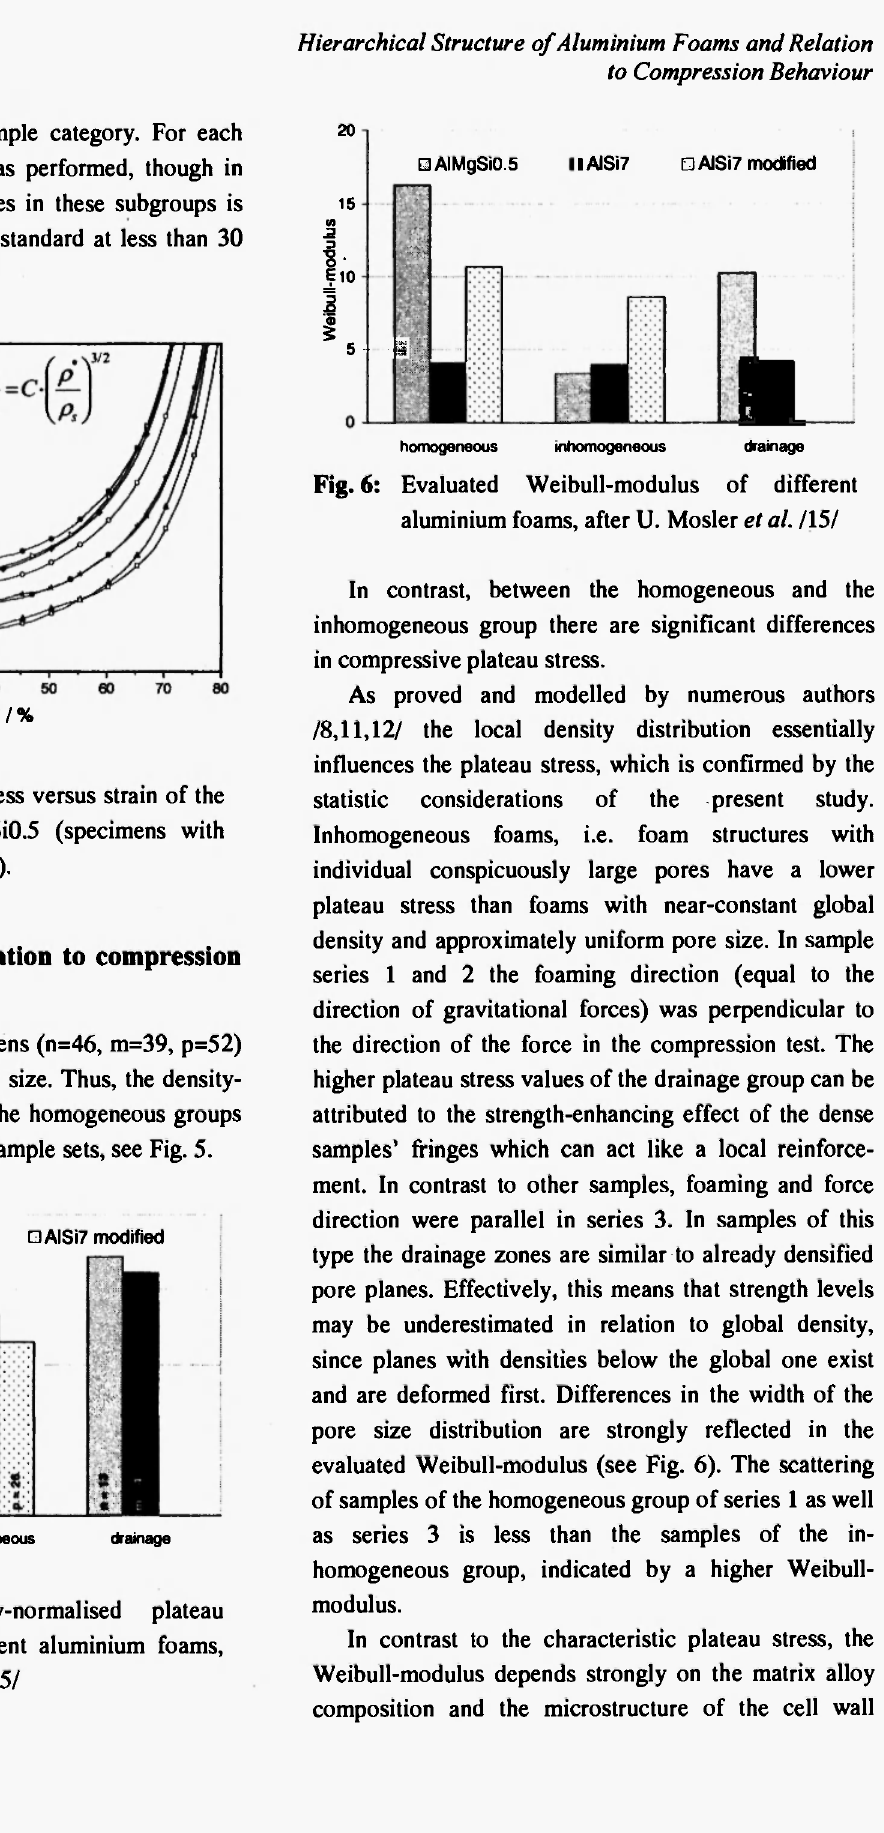
Fig. 5: Characteristic density-normalised plateau stress values of different aluminium foams, after U. Mosler et al. /15/